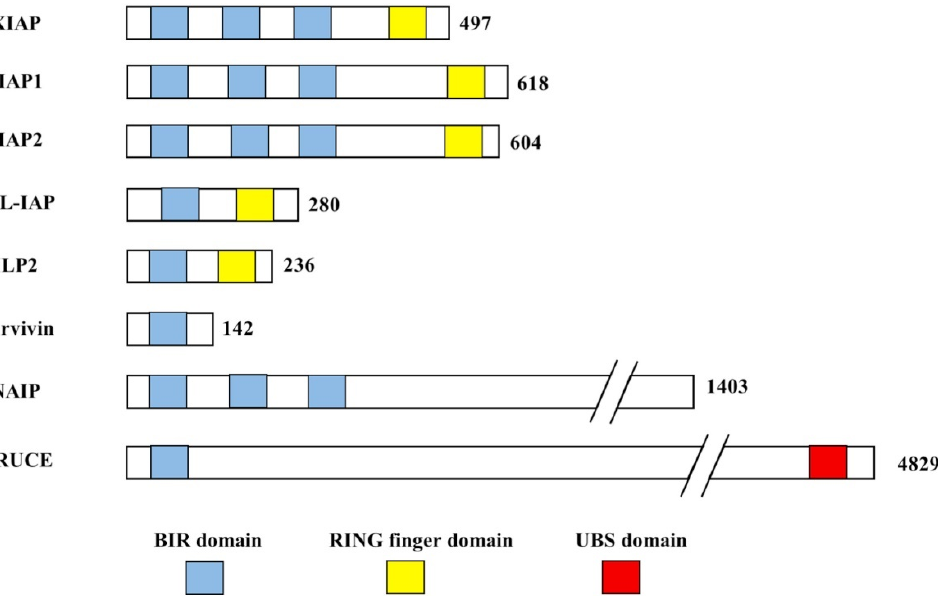
Figure 10. Available inhibitor of apoptosis protein (IAP) family proteins of humans.